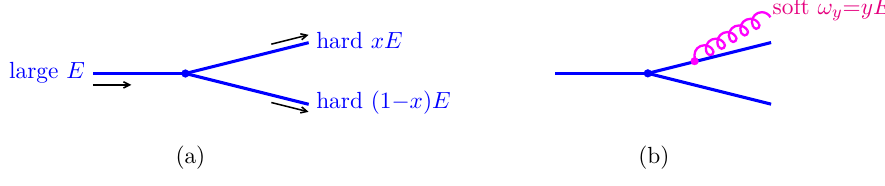
Figure 2 . (a) A hard, underlying splitting process (bremsstrahlung or pair production) with energies E → xE, (1 − x ) E . (b) One example of adding an additional, softer gluon bremsstrahlung, which should be understood as occurring during the formation time of the underlying, harder splitting process